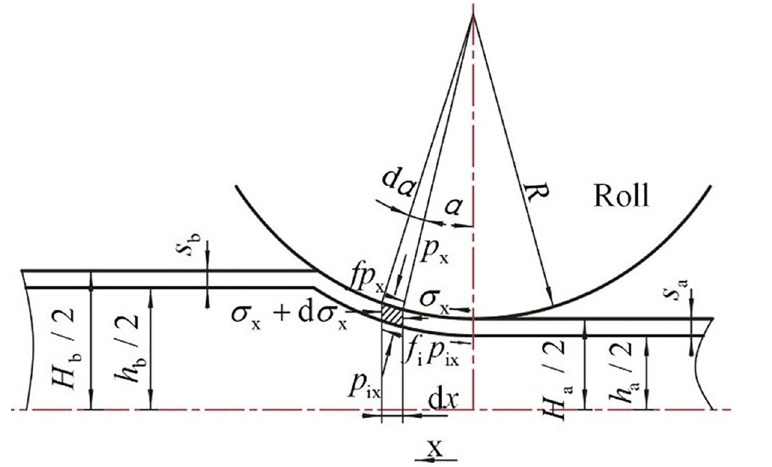
Fig 4. Stress analysis for the microunit of the steel